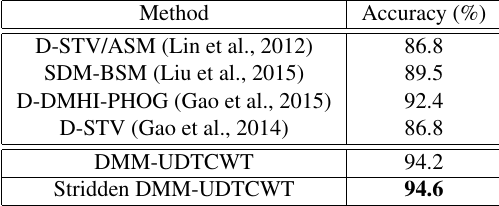
Table 3. Average recognition accuracies under Leave One Subject Out test on DHA